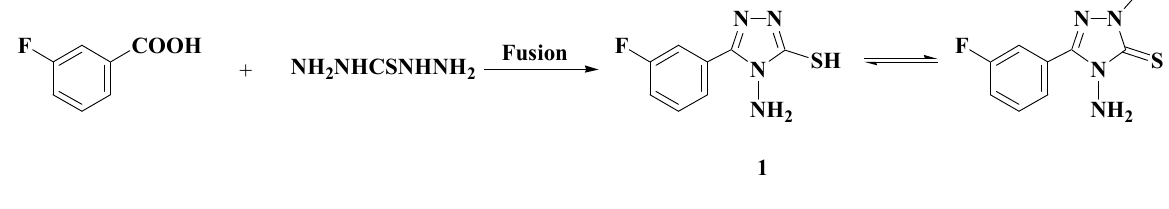
Scheme 2. Synthesis of Schiff Bases 2a – 2b